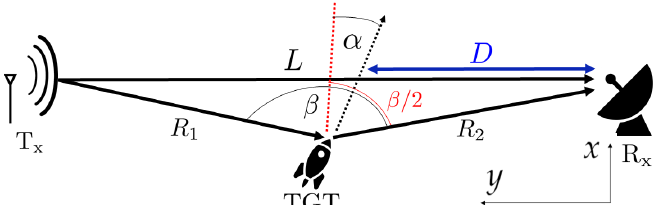
Figure 1. A typical passive forward scattering radar (FSR) geometry. T x —transmitter, R x —receiver, TGT—target, L —baseline, R 1 —range from the transmitter to the target, R 2 —range from the receiver